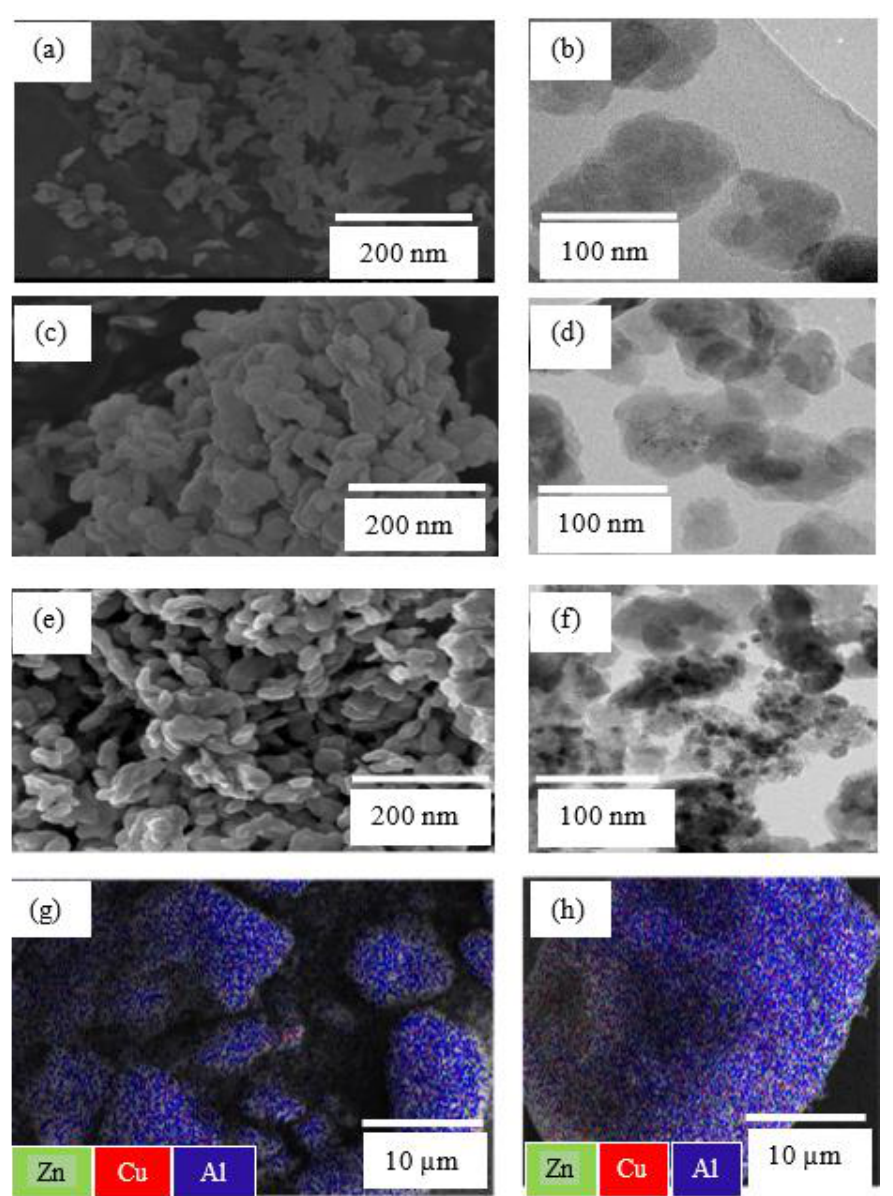
Figure 3. SEM and TEM images of: ( a , b ) AlFum MOF; ( c , d ) 7Cu/3ZnO/AlFum MOF; ( e , f ) 15Cu/6.4ZnO/AlFum MOF; EDX elemental maps of ( g ) 7Cu/3ZnO/AlFum MOF; and ( h ) 15Cu/6.4ZnO/AlFum MOF.